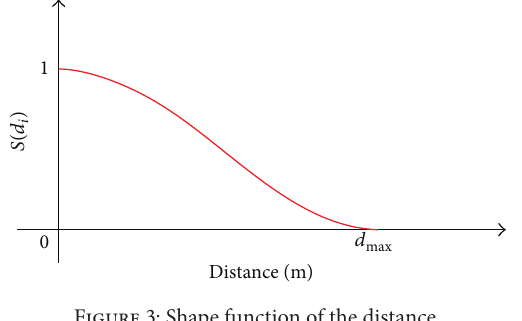
Figure 3: Shape function of the distance.